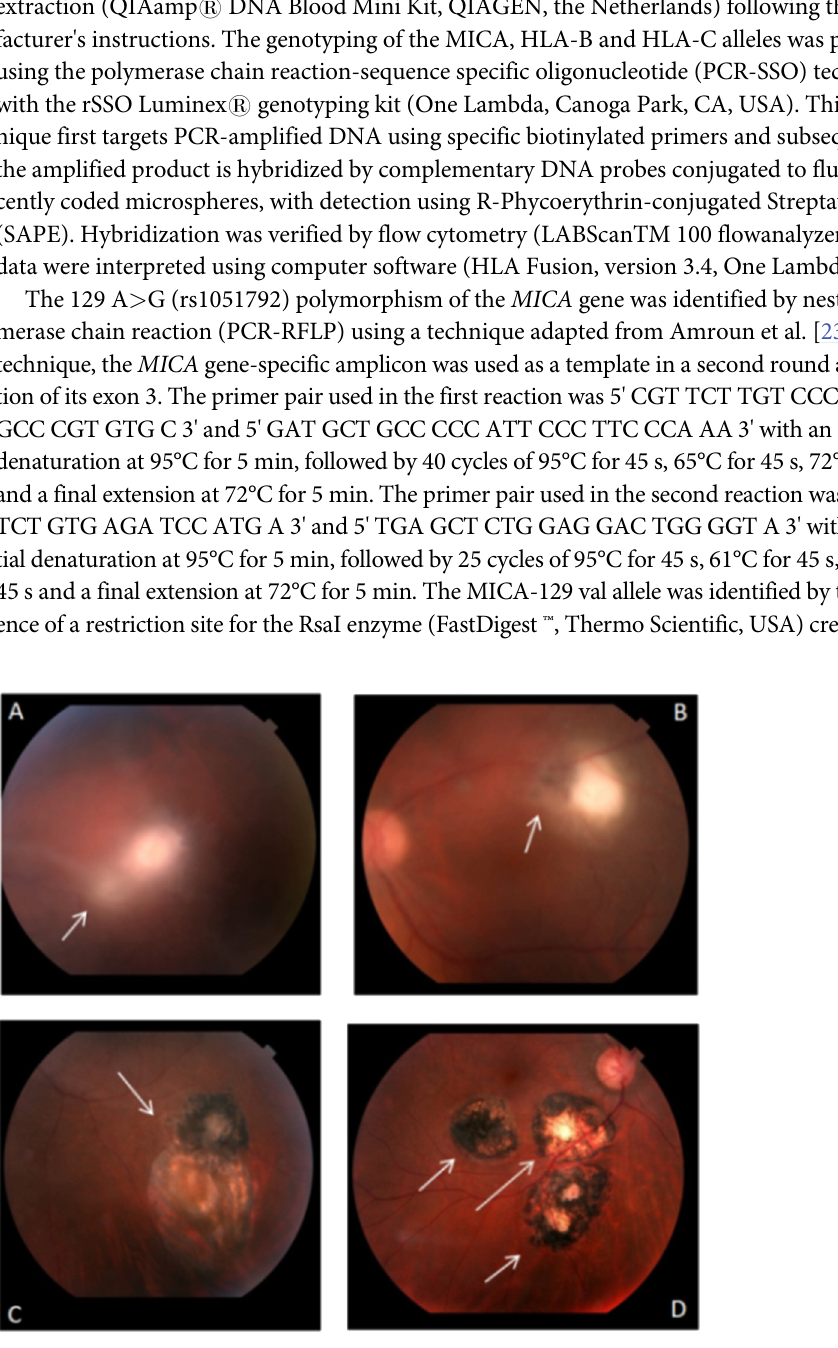
Fig 1. Colour retinography showing the various stages of eye lesions caused by Toxoplasma gondii infection in Brazilian patients. In (A) the arrow indicates the region with an acute exudative chorioretinal lesion ("lighthouse in the fog") and cloudy vitreous. In (B) the arrow indicates a chorioretinal lesions in the healing process — the patient had good clinical response to treatment and scar edges in definition. In (C) the arrow indicates presentation of an old chorioretinal scar and an old chorioretinal satellite lesion with pigment mobilization. In (D) chorioretinal scaring with well-defined edges indicated by the arrows with visualization of the